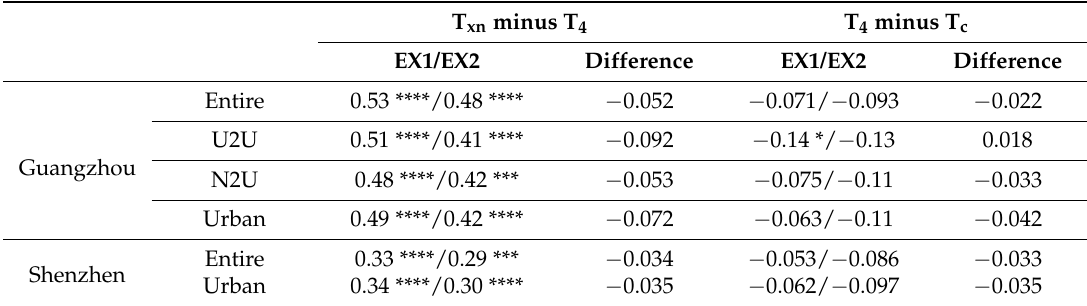
Table 2. The differences in 37-year annual mean SAT calculated using T 4 , T xn , and T c under EX1 and EX2, and the corresponding differences (EX2 minus EX1) over the subregions of Guangzhou (the entire, U2U, N2U, and urban areas) and Shenzhen (the entire and urban areas).